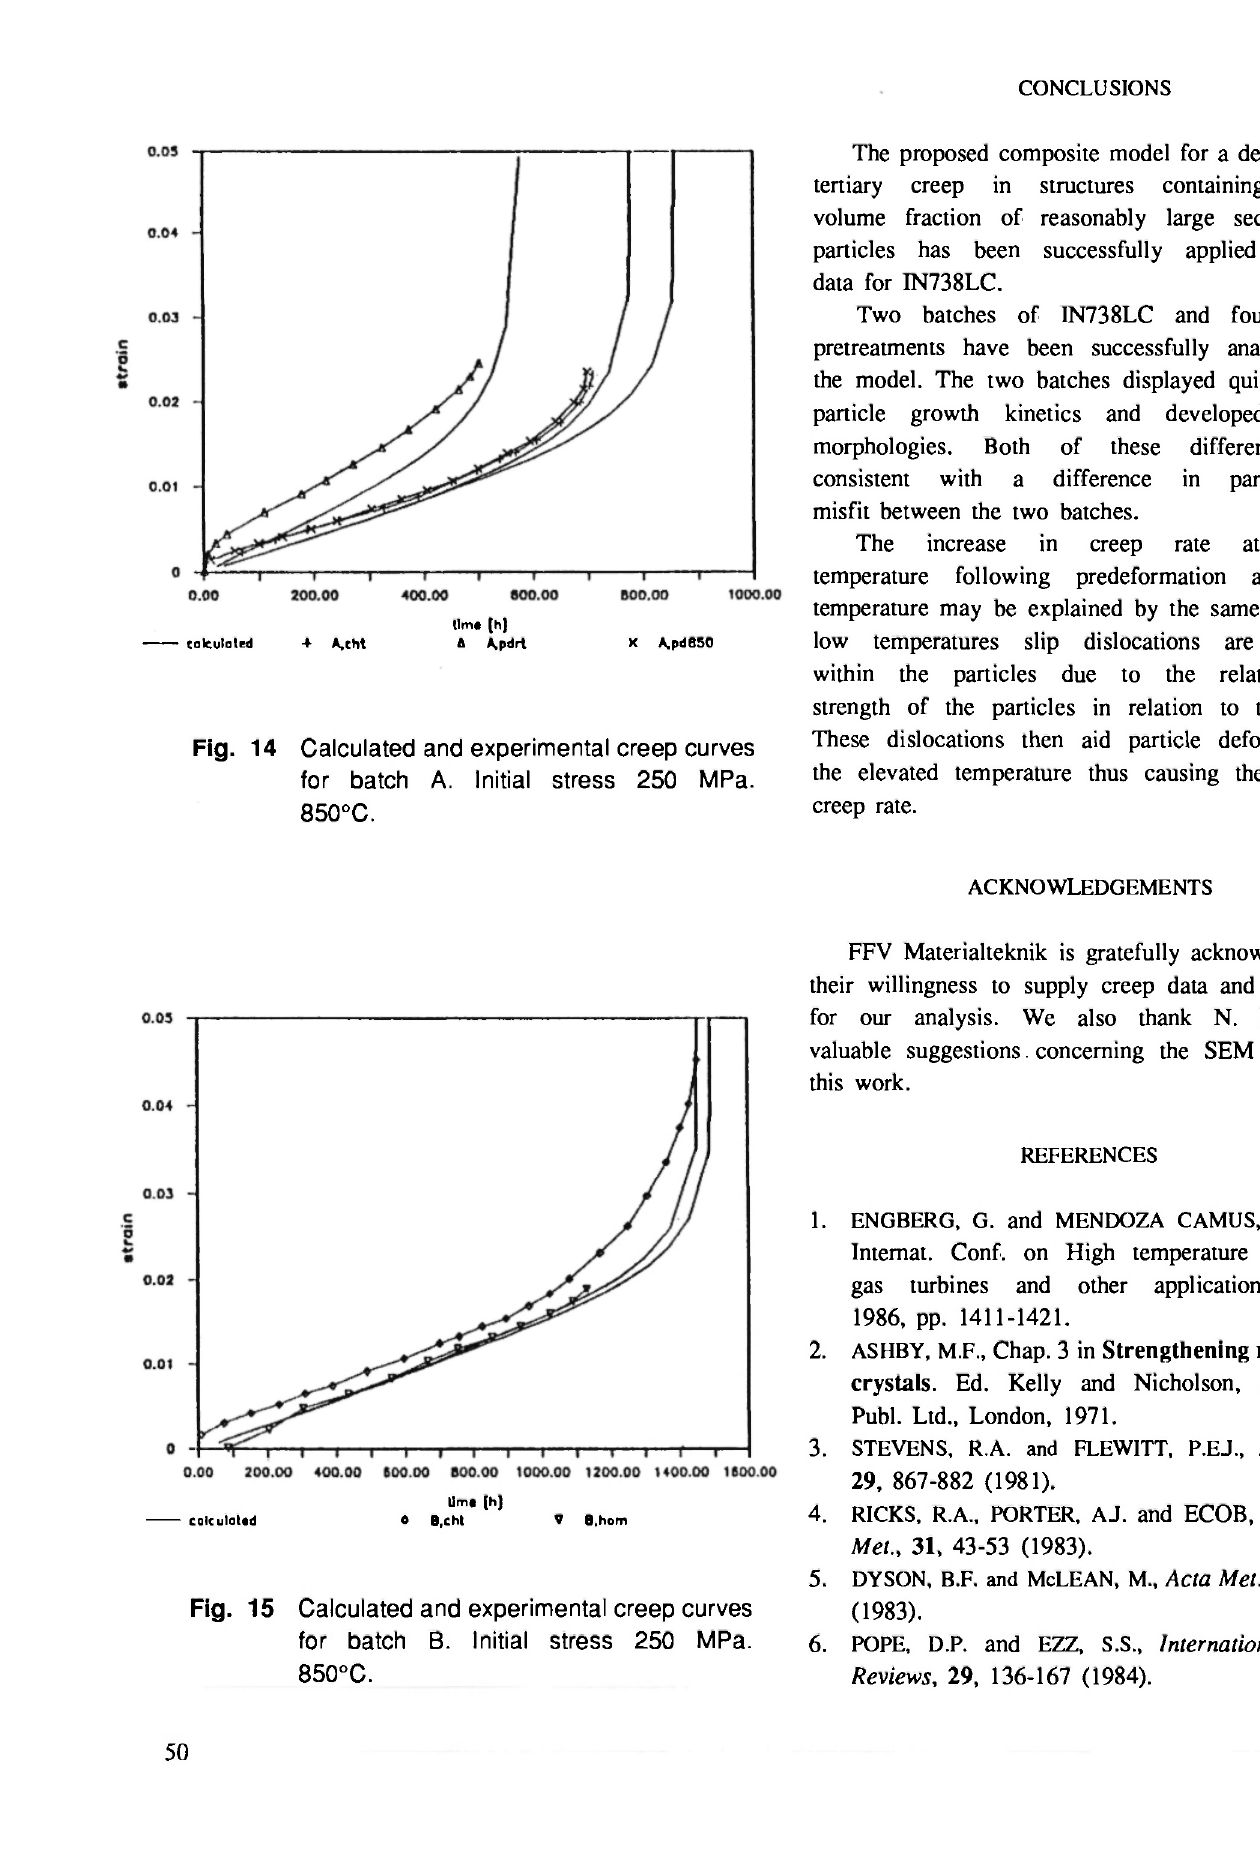
Fig. 15 Calculated and experimental creep curves for